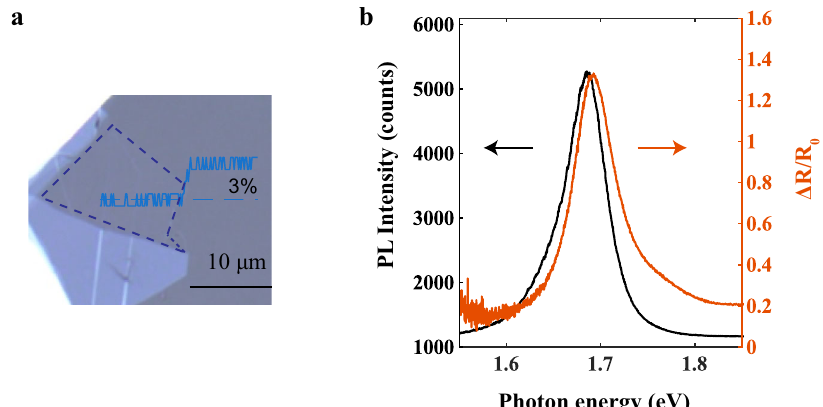
Fig. 1 Optical characterization of monolayer BP. a The optical image of BP on a PDMS substrate. The monolayer area is outlined by blue dashed lines. An optical transmittance line pro fi le is included in the fi gure to highlight the optical contrast of ~3% for monolayer BP. b Re fl ection contrast spectrum (red curve) and photoluminescence (black curve) spectrum. The narrow linewidth (~50 meV) and the small Stokes shift (the energy difference between ¼ 6 meV, imply the high-quality of the monolayer BP re fl ection and photoluminescence peak) of 4 Ref (cid:3) PL